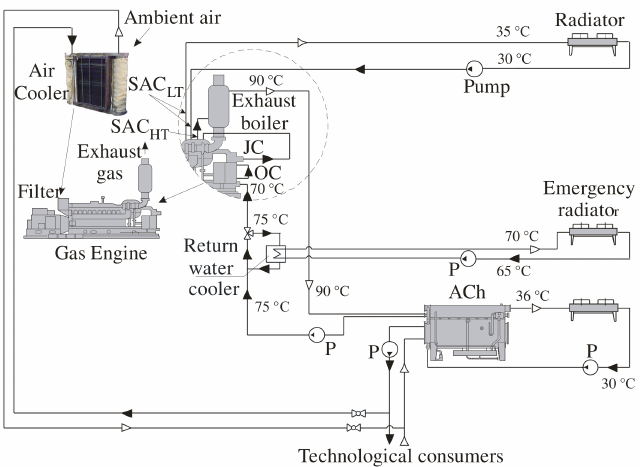
Figure 1. A schema of a typical system of cogenerative gas engine heat conversion by ACh with engine intake air cooling in the air cooler of the central conditioner by chilled water from the ACh: OC-oil cooler; JC-jacket cooler; SAC LT and SAC HT -low- and high-temperature scavenge air coolers. The efficiency of gas engine inlet air cooling is investigated for the trigeneration plant of “Sandora”–“PepsiCo Ukraine” (Mykolayiv, Ukraine). The trigeneration plant is equipped with two Jenbacher gas engines JMS 420 GS-N.LC (rated electric power P eISO =